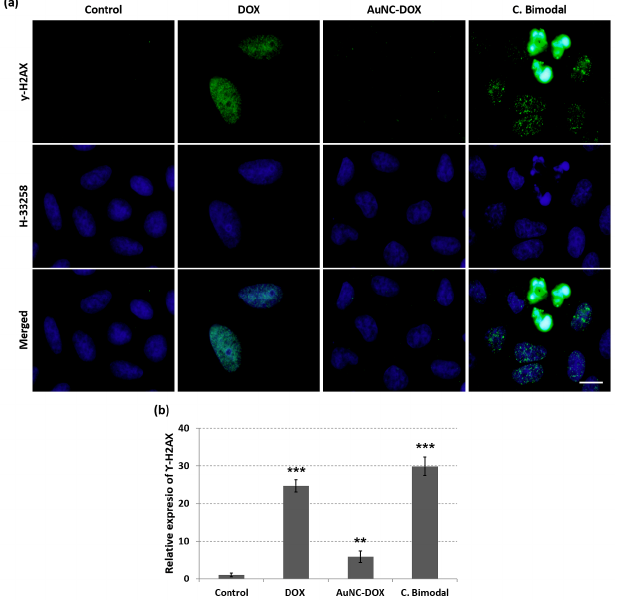
Figure 6. Attachment of DOX to AuNCs prevents DOX-induced double-strand breaks in HeLa nuclei. ( a ) Immunofluorescence of histone ƴ -H2AX (green) and H-33258 staining of DNA (blue) in untreated (control) cells and cells treated with DOX, AuNC-DOX, or combined bimodal treatment. Scale bar: 10 μm; ( b ) Quantification of relative expression of histone ƴ -H2AX on HeLa cells after each treatment. Statistically significant differences are labeled as ** p < 0.005, and *** p < 0.001.